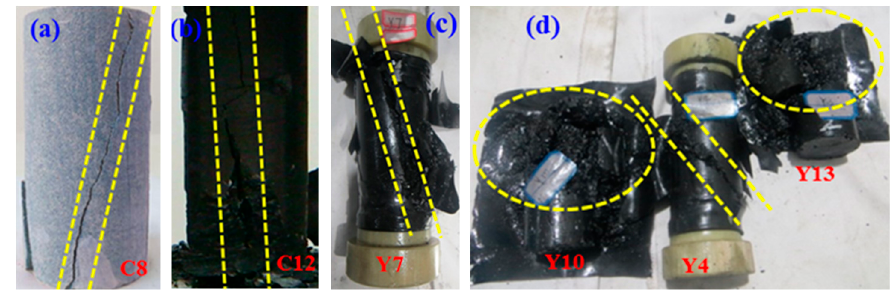
Figure 10. Failure modes observed in coal and sandstone specimens under the compression